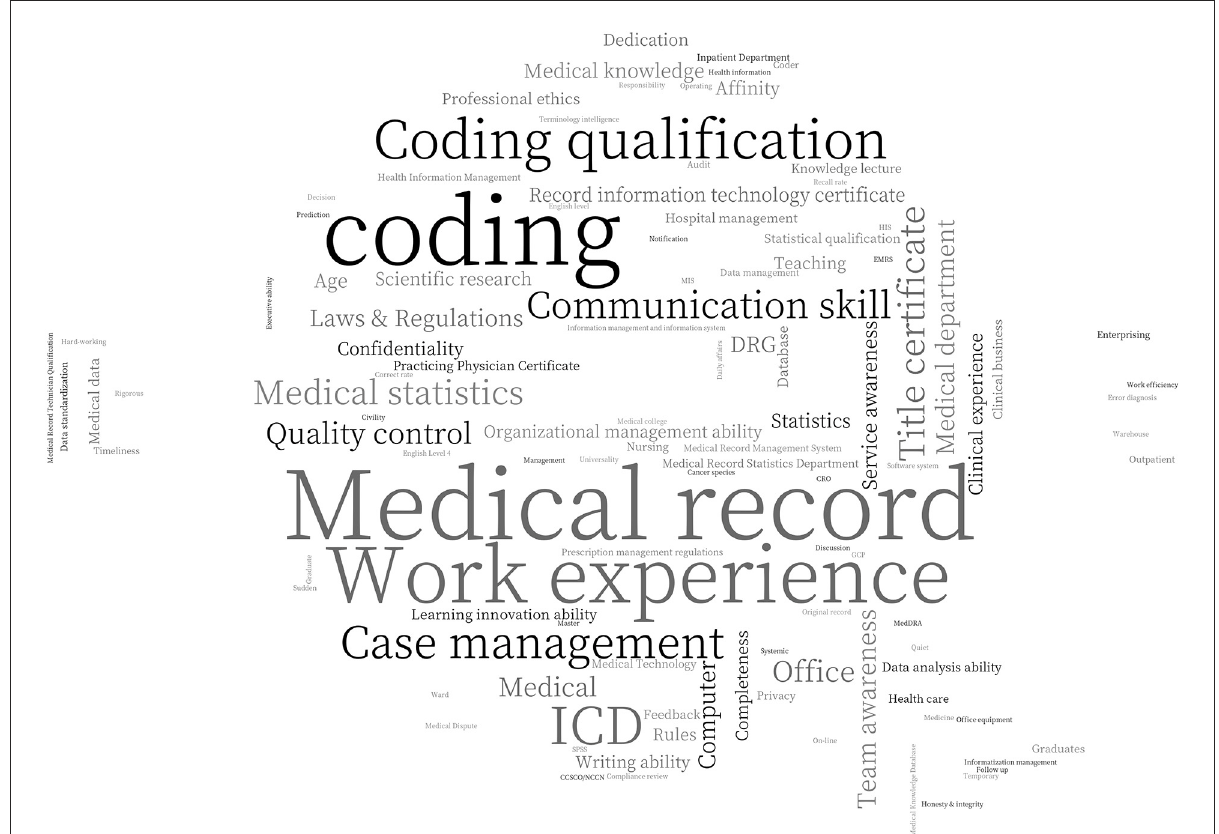
FIGURE3 Word cloud mapping of keyword frequency analysis (Edited in 2021/4,